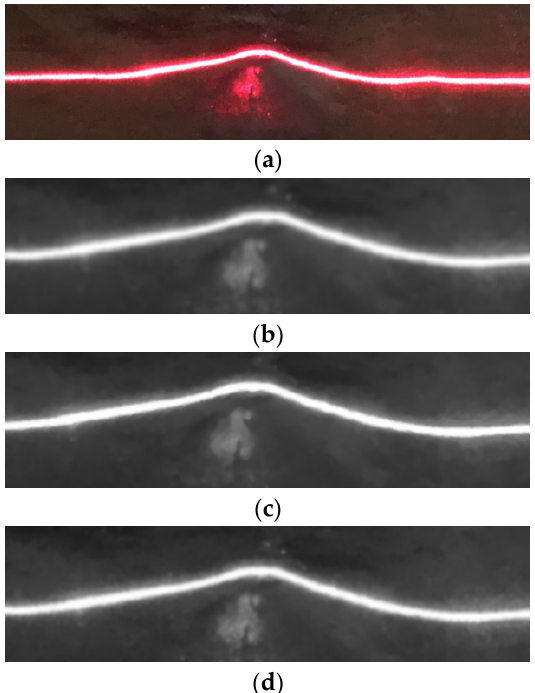
Figure 2. Initial image preprocessing: ( a ) represents the original image, ( b ) represents mean filtering, ( c ) represents median filtering, ( d ) represents Gaussian filtering.